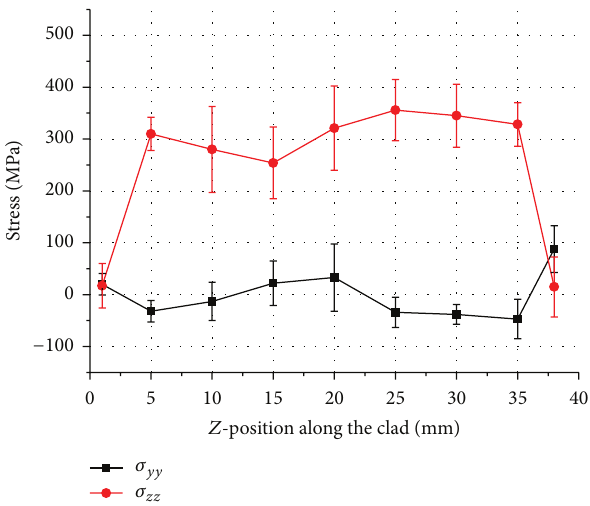
Figure 6: Stress result in sample 2, 0.7 DC pulsed laser deposition.